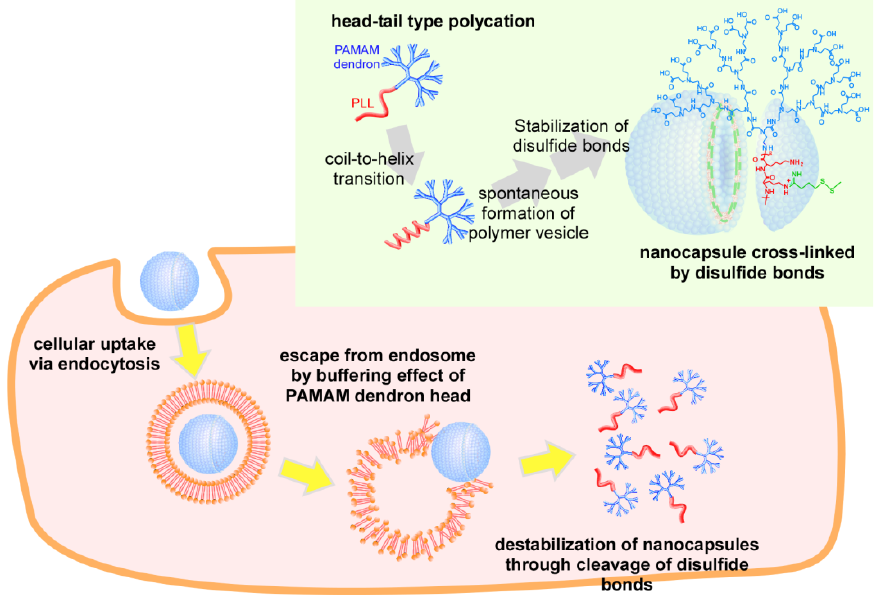
Figure 1. Schematic image of intracellular environment-responsive nanocapsules prepared from head-tail type polycations by the stabilization of disulfide